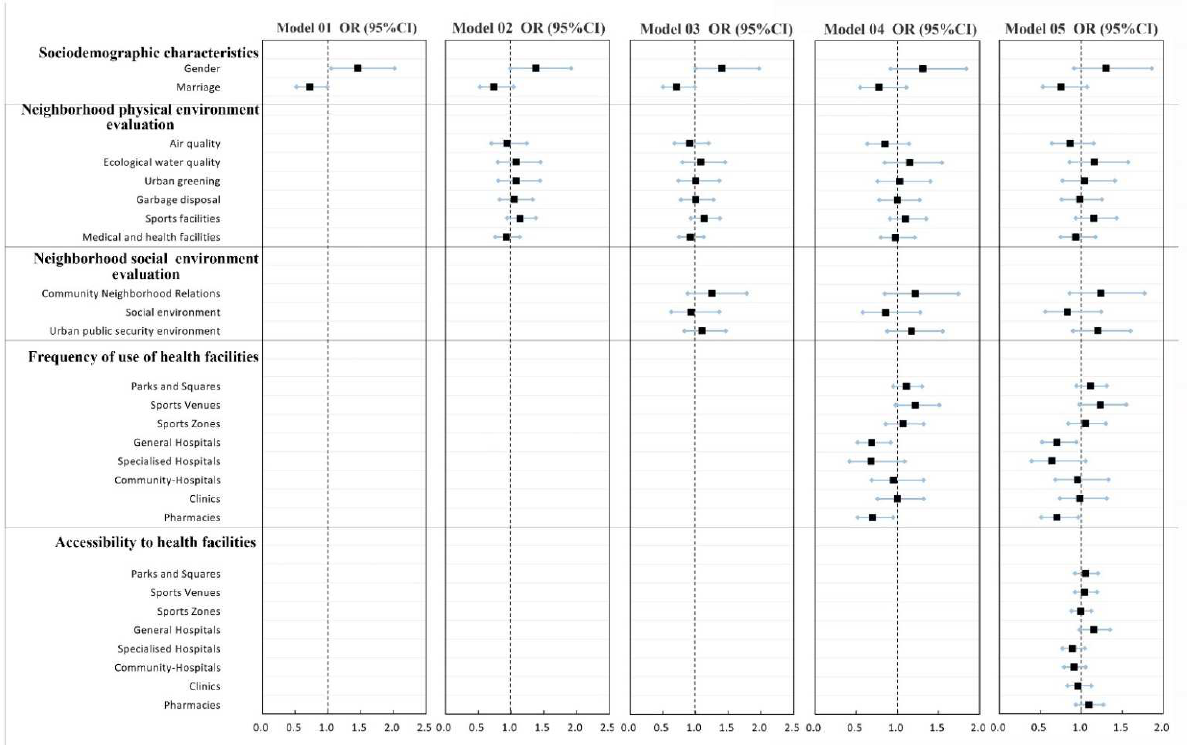
Figure 5. Ordered Logistic Regression Analysis of SRPH.